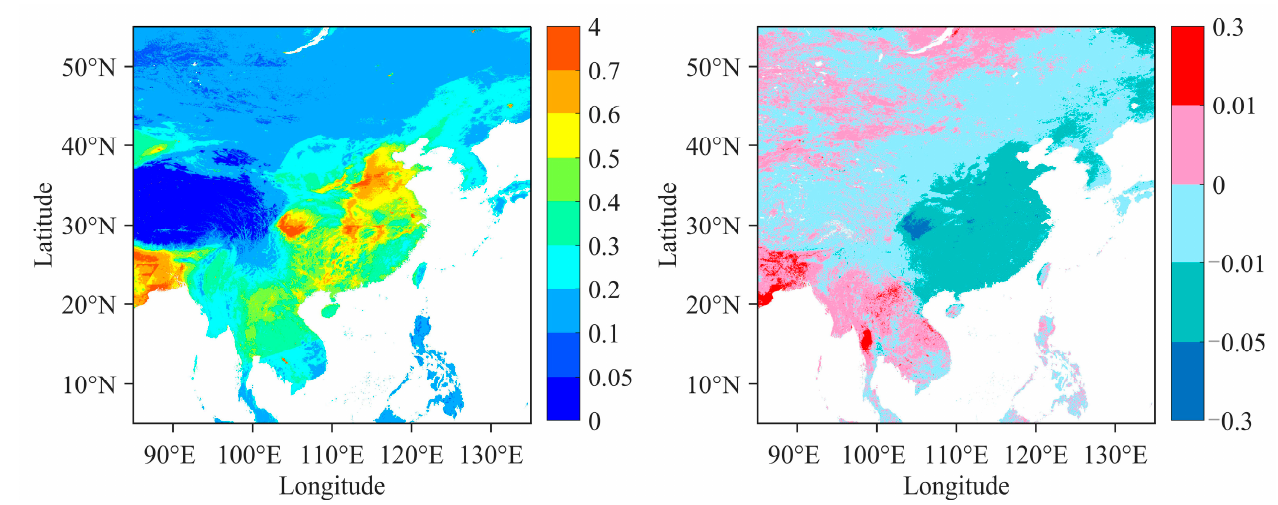
Figure 7. Spatial distribution and change rate of MAIAC AOD from 2011 to